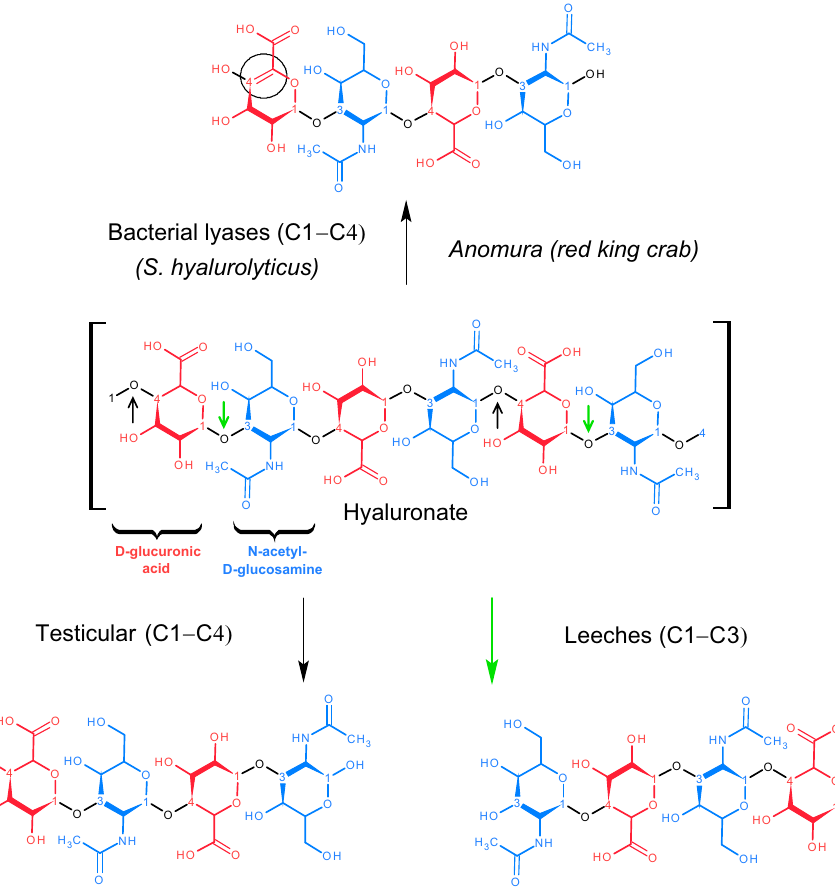
Figure 1. The structure of HA and the products of the hydrolysis reaction by different classes of hyaluronidases. Small arrows in the picture of the HA structure indicate the places of the bond break (green arrows—leeches, black—the rest), a circle marks the double bond between C-4 and C-5 glucuronic acid atoms, which is formed during the β -elimination of HA.